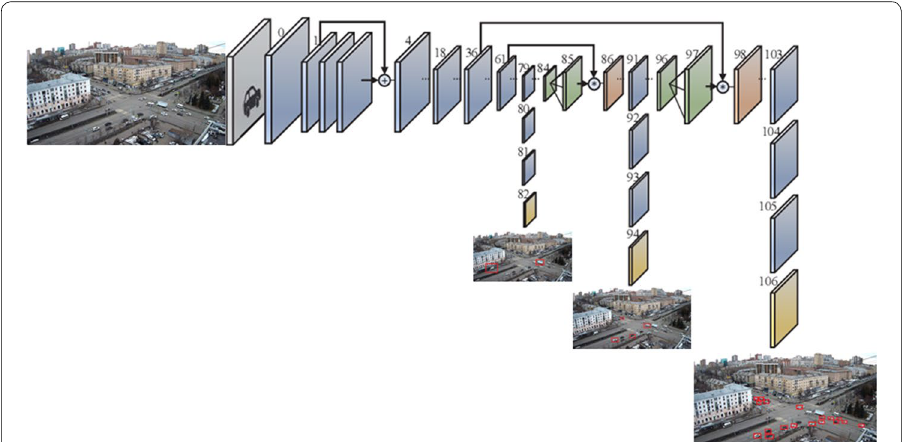
Fig. 6 The architecture of YOLO v3 [21]